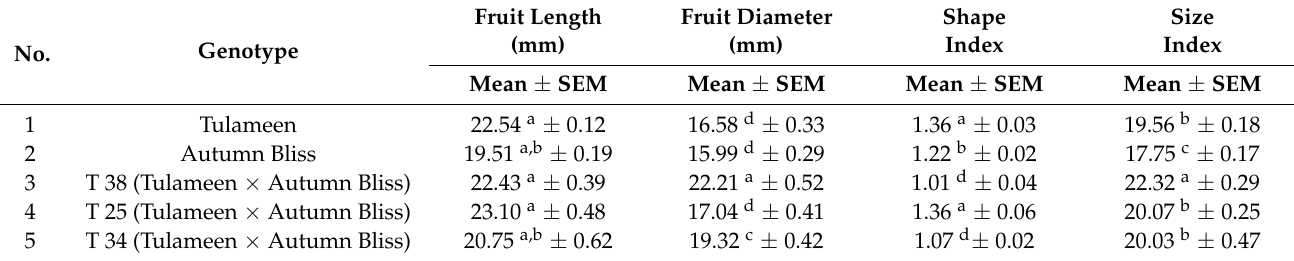
Table 1. The average values of fruit length, fruit diameter, shape index, and size index for 24 raspberry genotypes (14 promising selections (clones), their parents, and Glen Ample cultivar as con- trol).